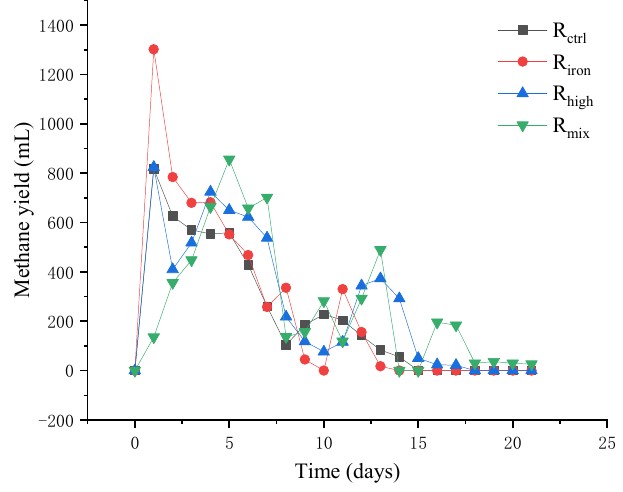
Figure 1. Methane yield of the four